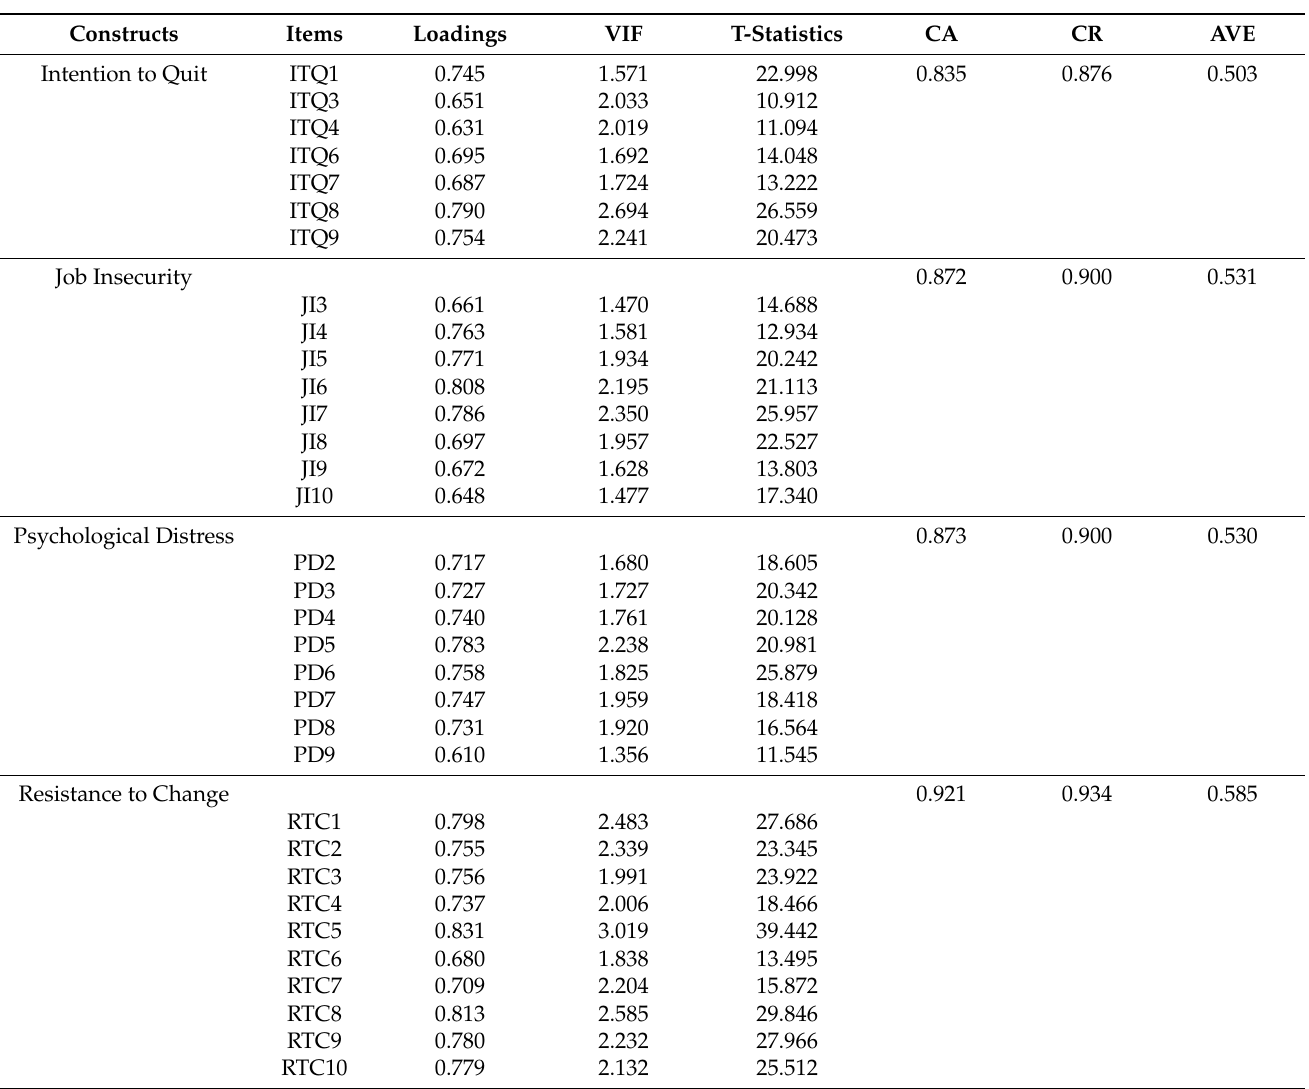
Table 2. Measurement model